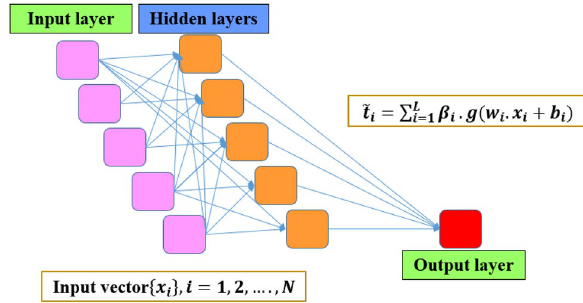
Figure 1. Structure view of ELM